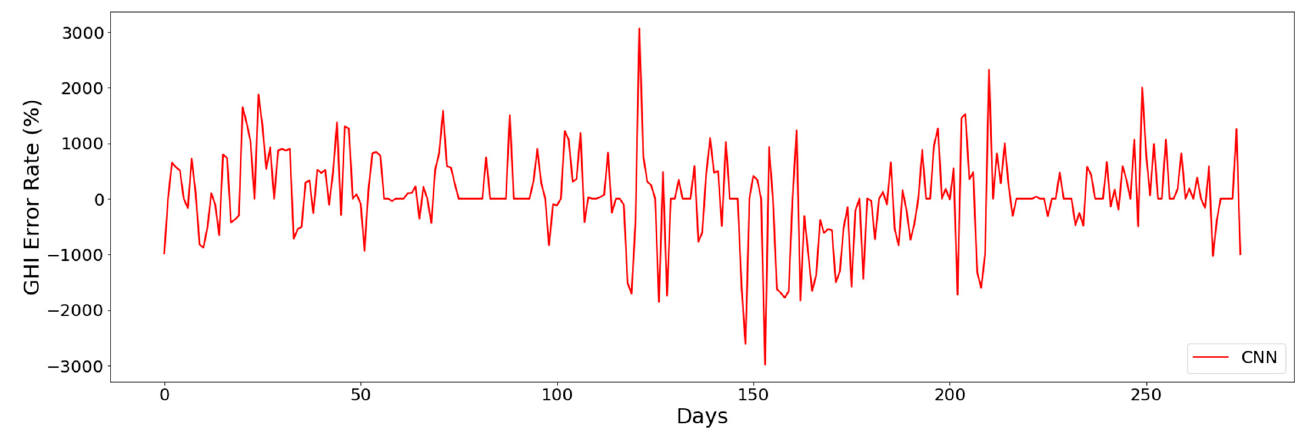
Figure 7. Graphical representation of CNN (DL) predictions.